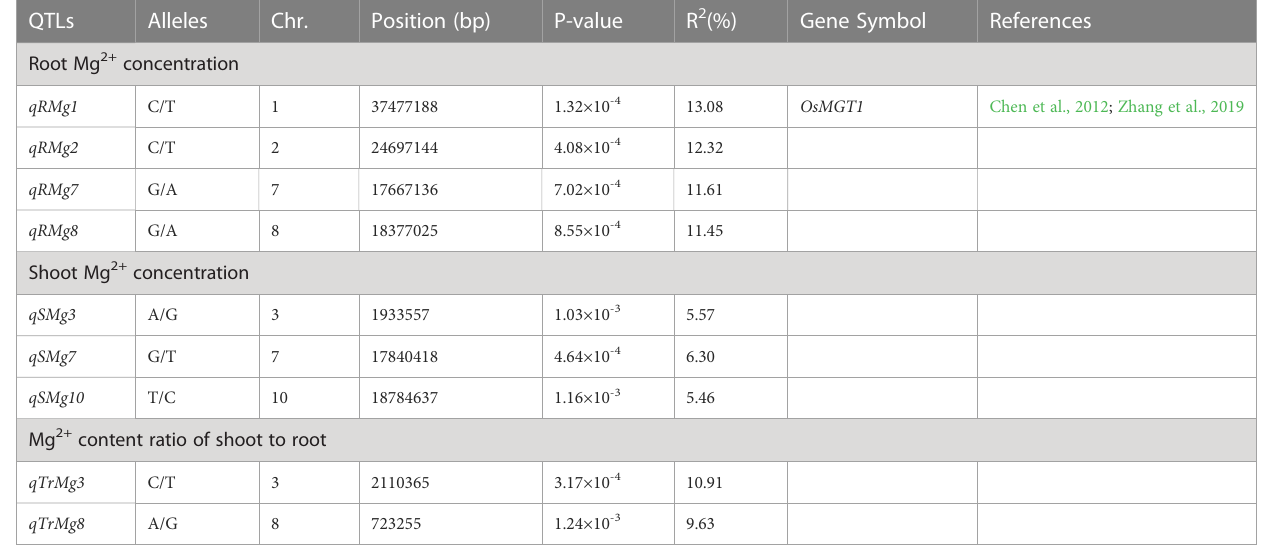
TABLE 2 QTLs for Mg 2+ uptake and translocation detected in the DC1 MAGIC population.